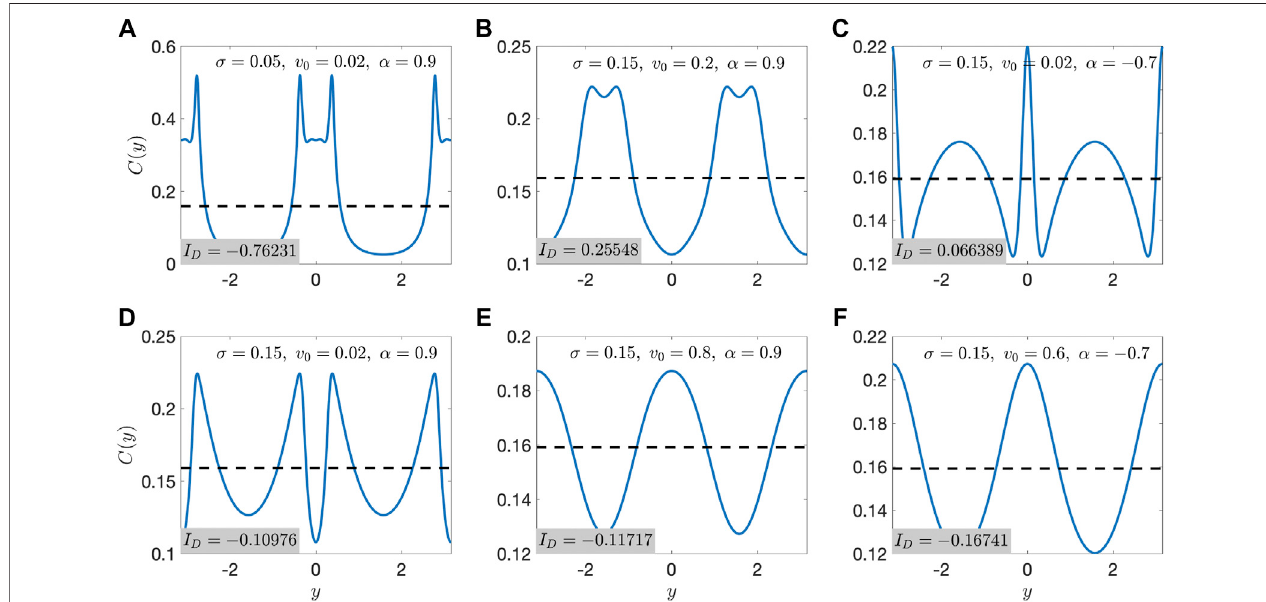
FIGURE5| Concentrationpro fi les C ( y )forvariouscombinationsof σ , v 0 ,and α correspondingtothoseusedin Figure4 . PanelsA – D areforparametersbeforethe bifurcation from rotational to cross-stream drift, and panels E and F are after this bifurcation. The dashed lines show the uniform concentration pro fi le, to highlight the nonuniformity of the swimmer concentrations C ( y ). The depletion index I D for each parameter is noted on each panel.